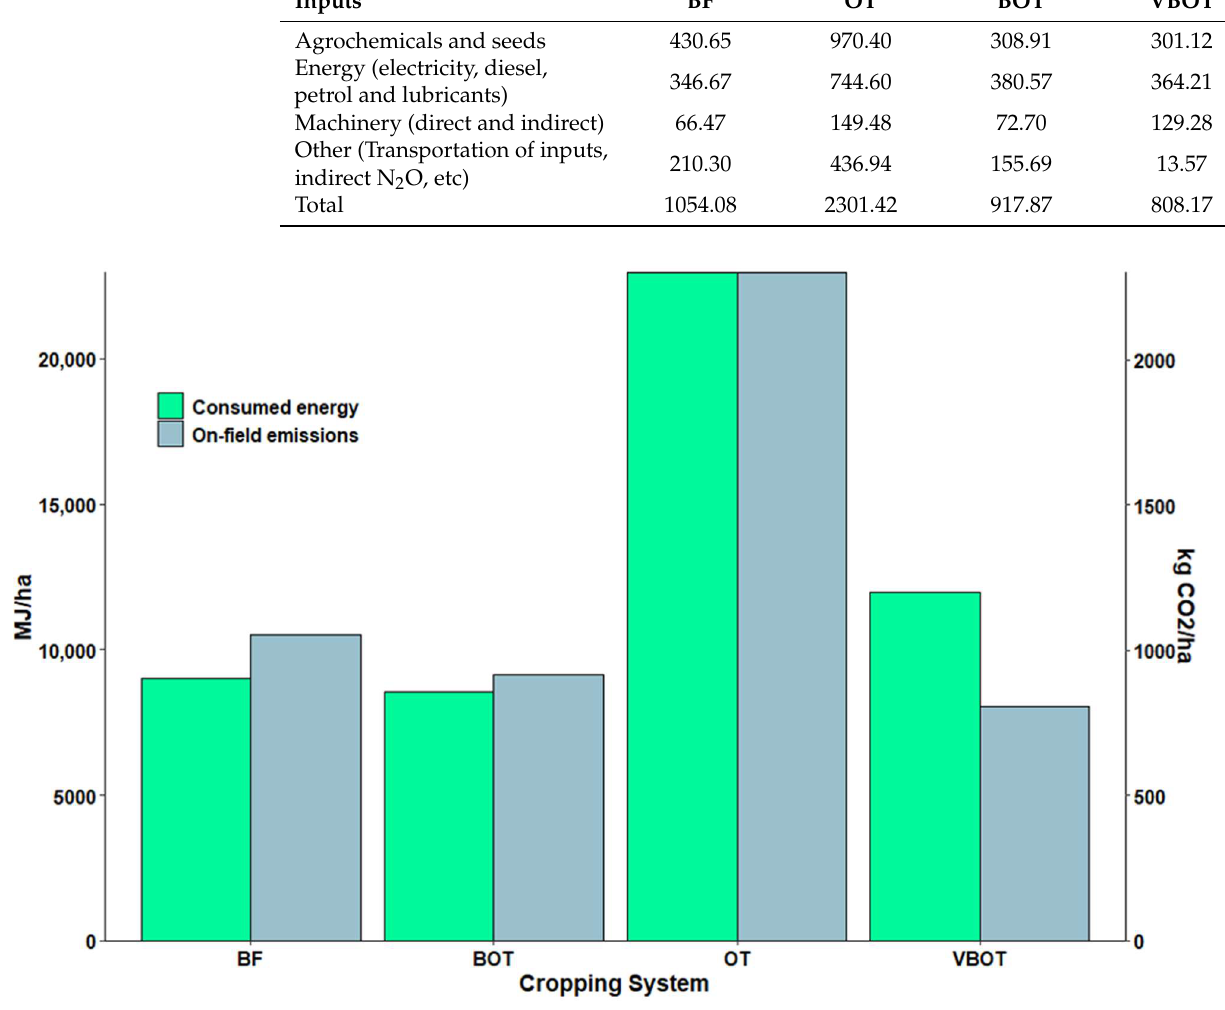
Figure 2. Consumed energy (MJ/ha) and on-field emissions for the four cropping systems.